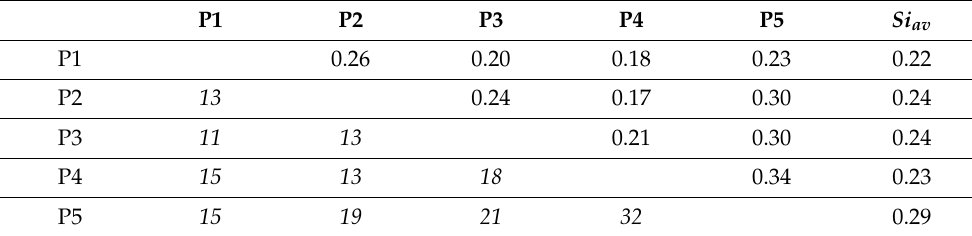
Table 1. Sorensen similarity index